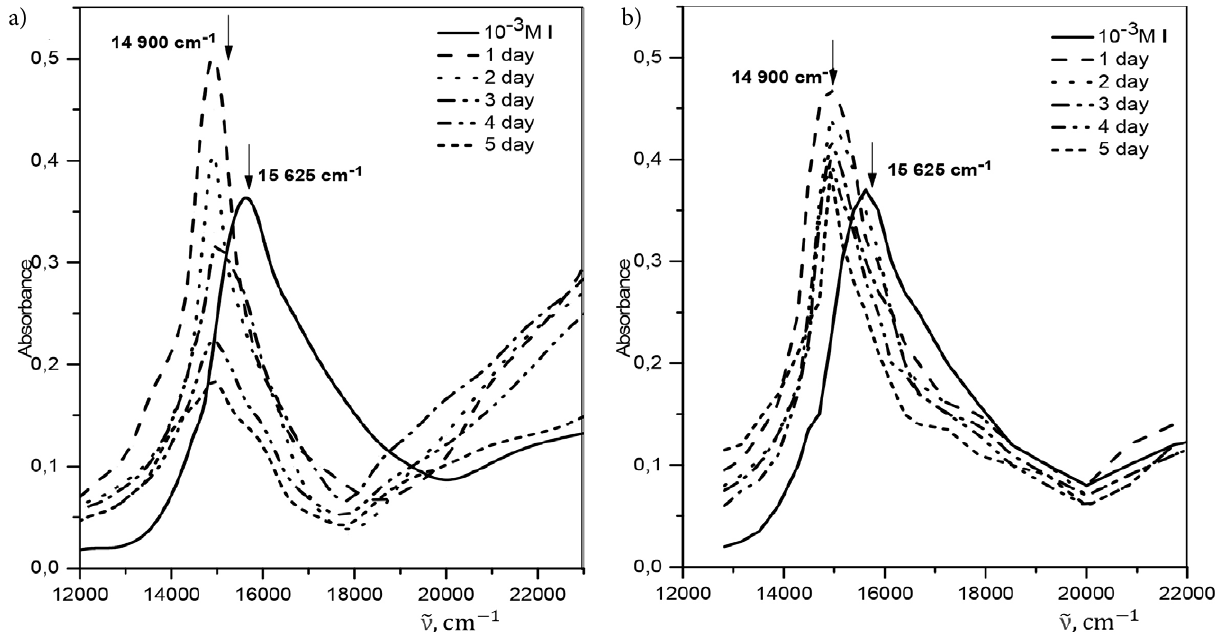
Fig. 2 EAS of the reaction mixture of I (10 –3 M ) and ZrP in IPA: a) at 1:30 ratio over time; b) at 1:5 ratio over time; control –